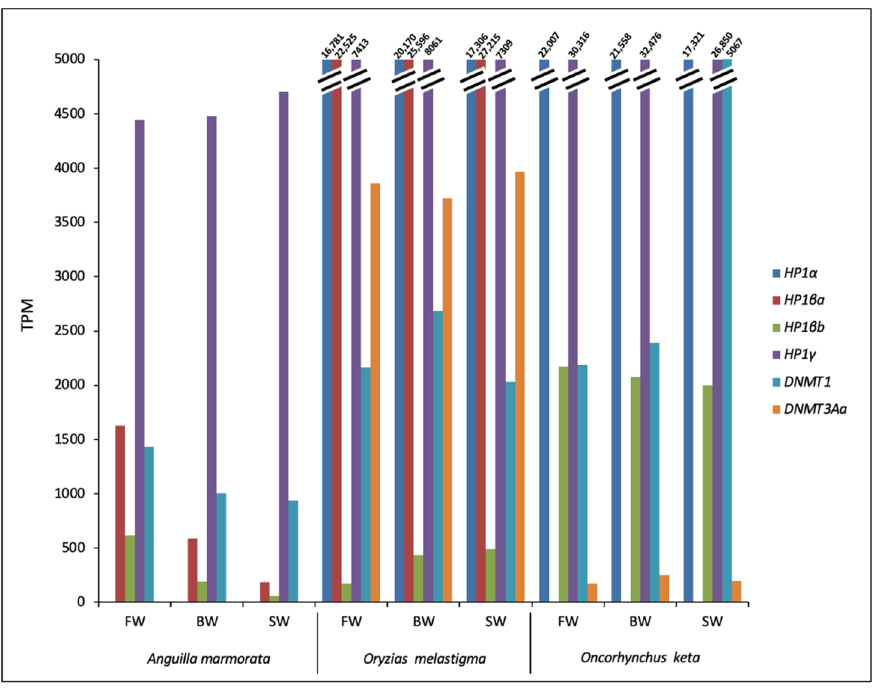
Figure 3. Transcriptional activity of genes involved in heterochromatin formation in Anguilla marmorata, Oryzias melastigma, and Oncorhynchus keta gill transcriptomes. FW: freshwater; BW: brackish water; SW: salt water.